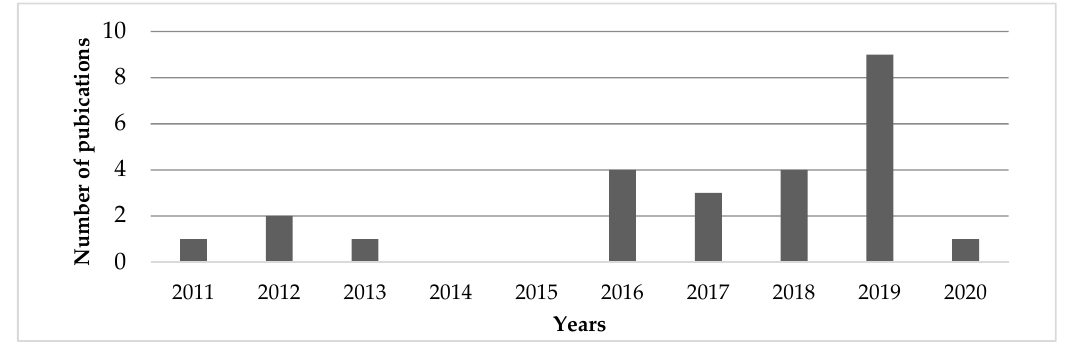
Figure 3. Number of publications produced between the years 2011–2020 [15].